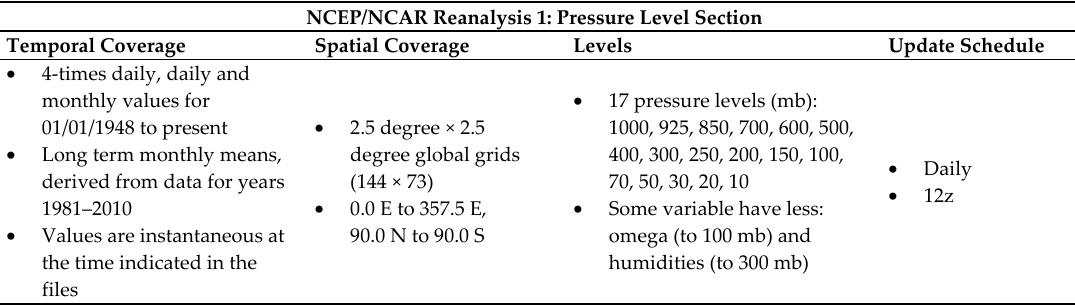
Table 1. Information from [22]; specification for this research to download plots from the pressure